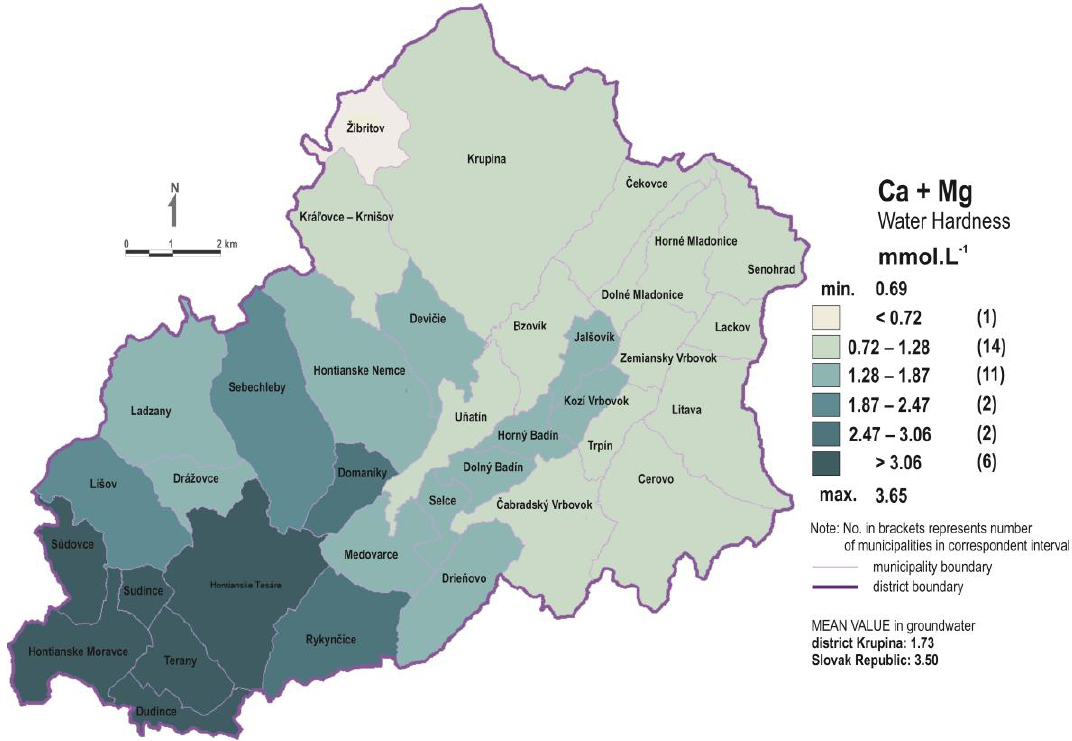
+ Mg (in mmol · L − 1 ) within the